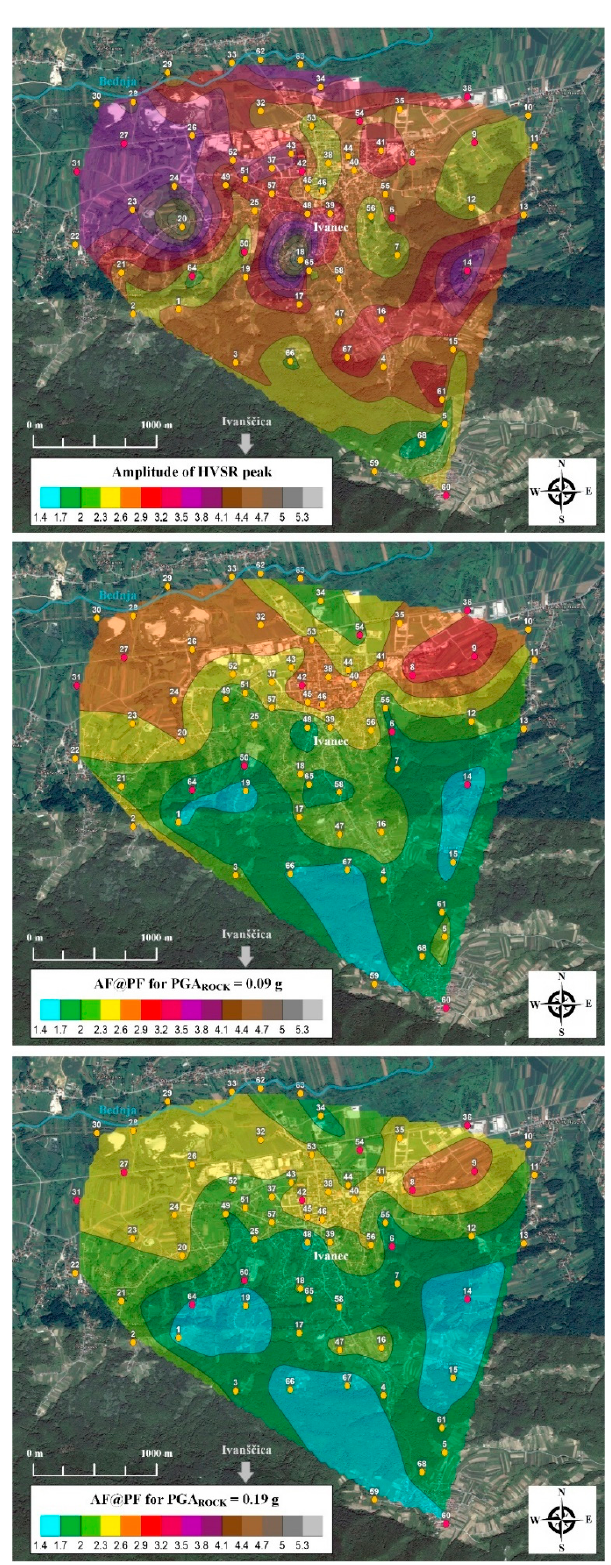
Figure 13. Up: Map of the amplitude of HVSR peak at fundamental HVSR frequency. Middle: Map of site response amplification factor at predominant frequency for input PGA ROCK = 0.09 g (95yrp). Bottom: Map of site response amplification factor at predominant frequency for input PGA ROCK = 0.19 g (475yrp). The same colour scale for the amplification is used in all three cases.